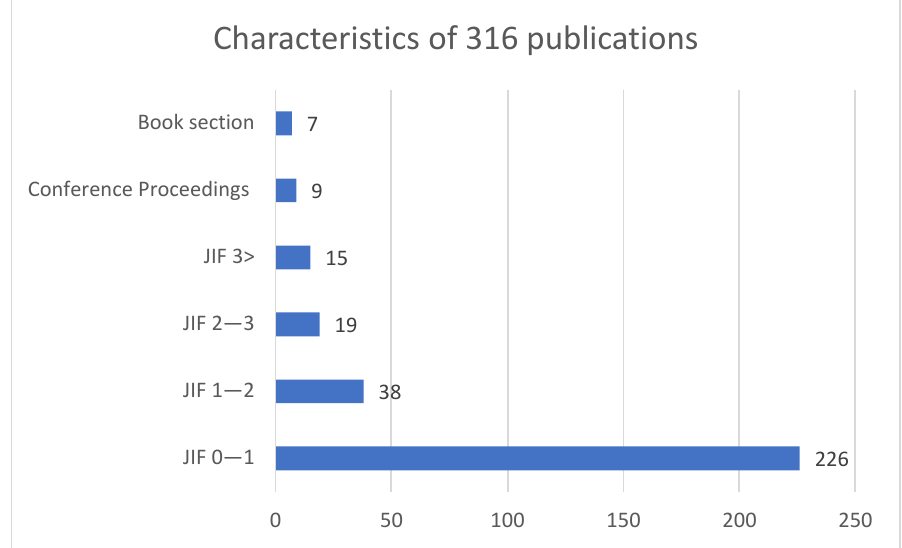
Figure 1. Characteristics of 314 publications from the final sample.